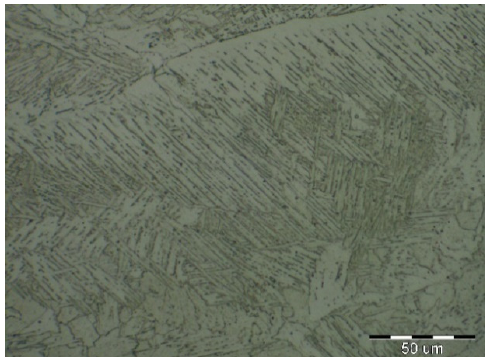
Figure 10. Coarse-grained microstructure of HSLA steel in the middle of the weld metal.